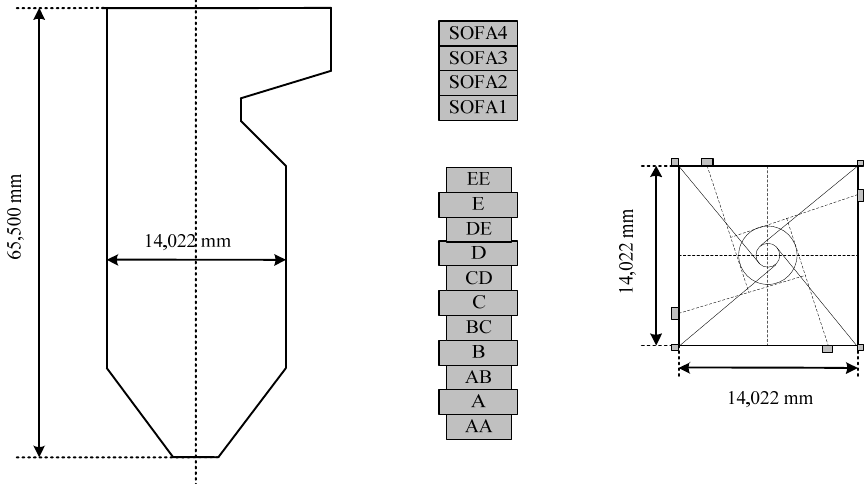
Figure 1. Schematic diagram of the furnace.